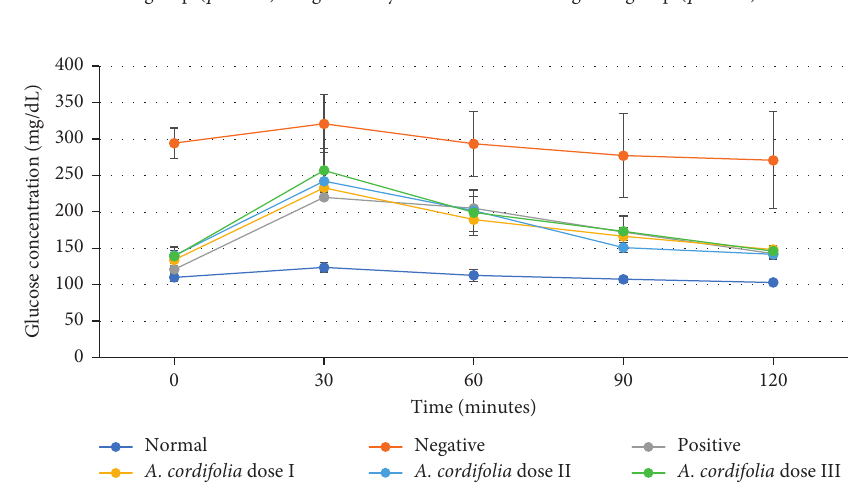
Figure 1: Oral glucose tolerance test. The administration of glucose leads in high blood glucose of diabetes mellitus model rats (negative control groups) at 0 times to 120minutes after administration. The glibenclamide-treated rat (positive groups) and three doses of A. cordifolia leaf extract-treated rats could decrease the concentration of blood glucose after 30minutes of glucose administration. The glucose level in the blood is expressed in mg/dl. The values indicate means ± SD of five rats per